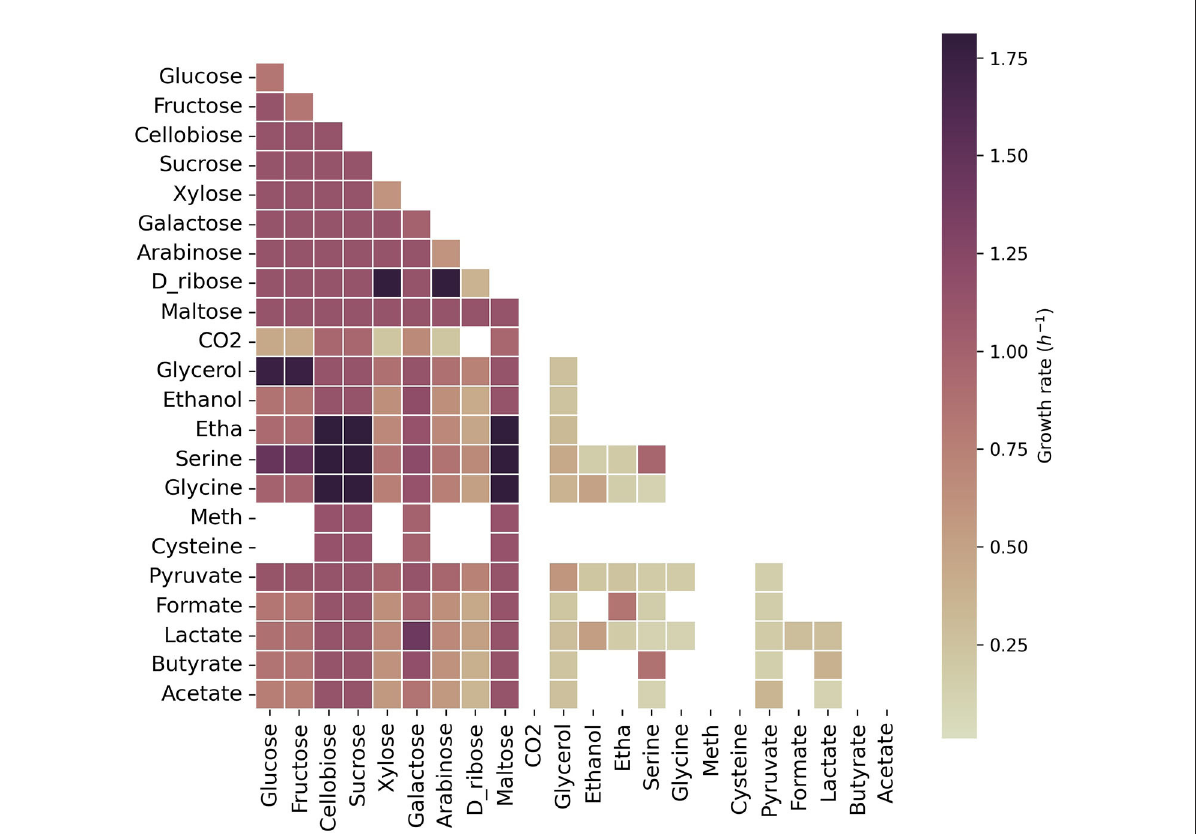
FIGURE2 Growth capabilities predicted for C. acetobutylicum . The color scale shows growth rates in h -1 . Squares on the diagonal correspond to single carbon sources. Squares below the diagonal correspond to the combination of the carbon source presented on the x-axis with the carbon source presented on the y-axis. Non-colored squares show that no growth was predicted for the specified carbon source(s). Meth, methionine; Etha, ethanolamine. The maximum uptake rate for each carbon source was set to 20 mmol g DW-1 h -1 and the minimum to 0.1 mmol g DW-1 h -1